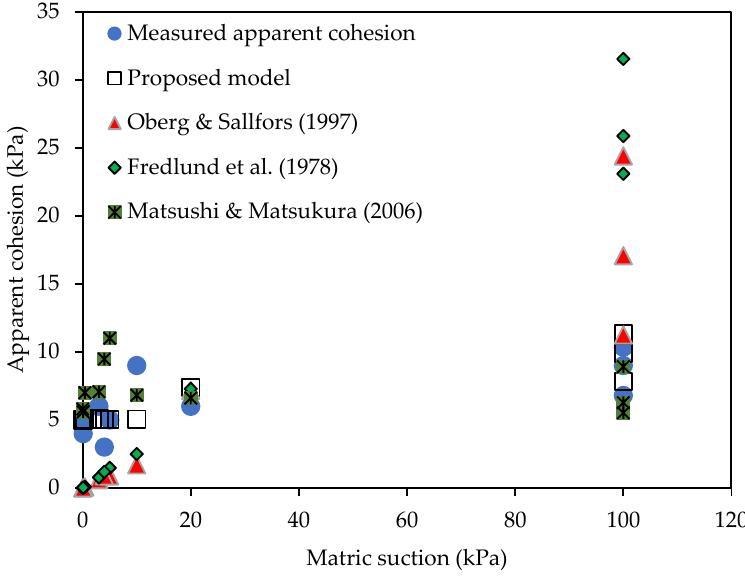
Figure 4. Predicted apparent cohesion vs. measured apparent cohesion (After [23,24,27]).